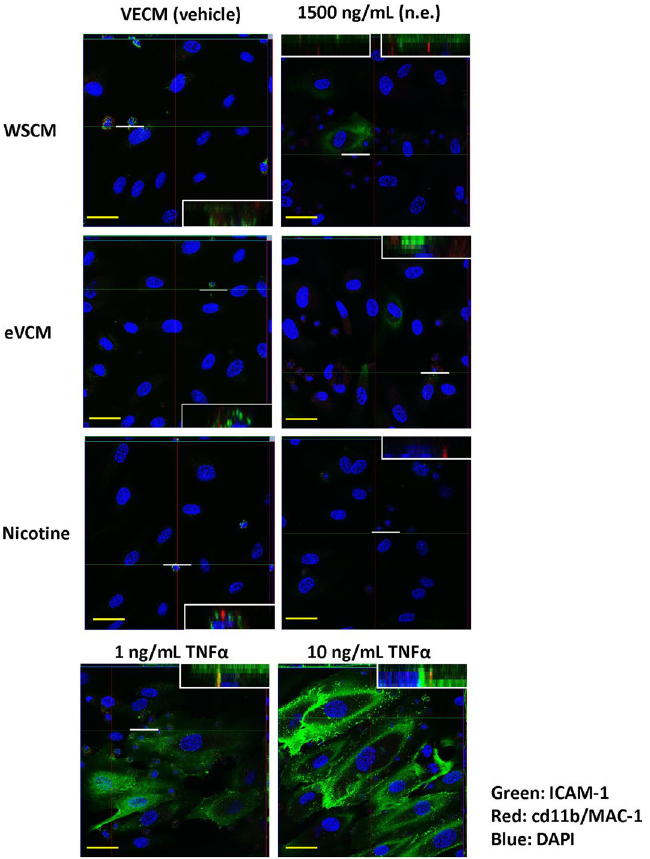
Figure 6. Analysis of ICAM-1 and CD11b co-localisation in HAECs following 24 h exposure to test article in the BioFlux microfluidic system. Immunofluorescence microscopy analysis of ICAM-1 and CD11b/MAC-1 co-localisation between monocytes and HAECs following 24 h WSCM, eVCM or nicotine exposure in BioFlux microfluidic channels. Monocyte adhesion to HAECs was assessed over a course of adhesion periods (10, 20, 30 and 40 min). Images were captured after the 40 min adhesion period using a Zeiss LSM780 confocal microscope (×40 magnification). Scale bar (yellow line) = 35 µm. To assess co-localisation, z-planes were applied through the composite z-stack. Inset images represent z-planes from regions marked with a white